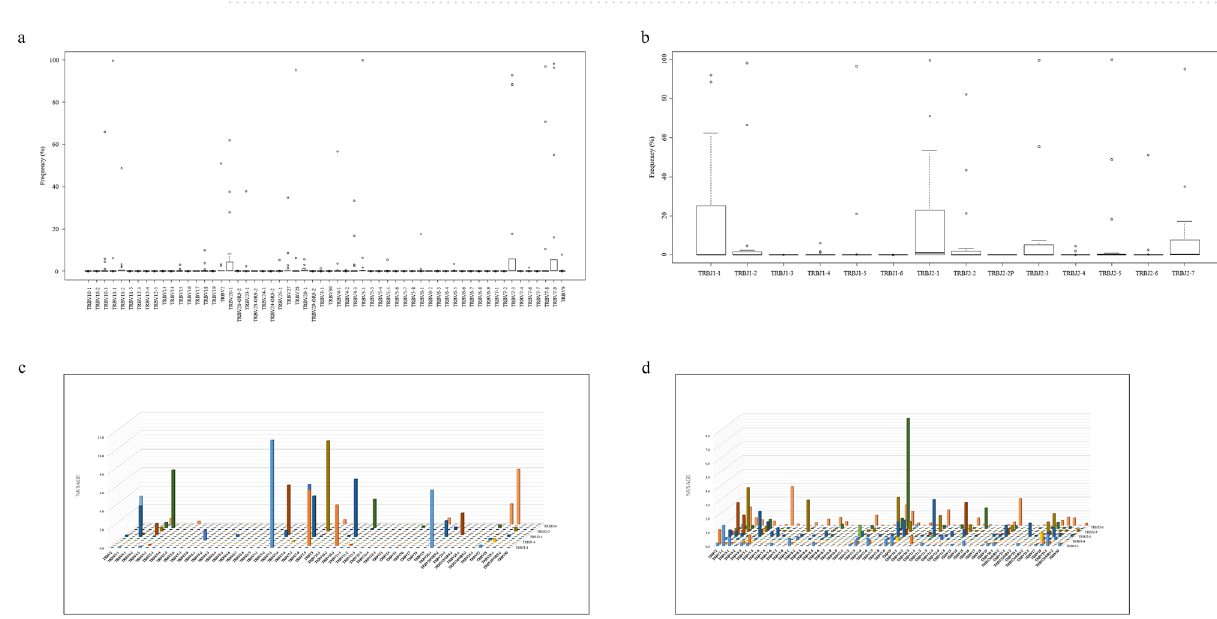
Figure 3. Characteristics of cytomegalovirus (CMV)-specific T-cell receptors (TCRs). ( a , b ) Boxplot representing TRBV ( a ) and TRBJ ( b ) usage of CMV-CTLs. ( c , d ) 3D graphical representation of the TCR repertoire of CMV-CTLs ( c ) and entire T cells ( d ) at the time of CMV reactivation. The X and Y axes indicate TRBV and TRBJ segments, respectively, and the Z axis indicates